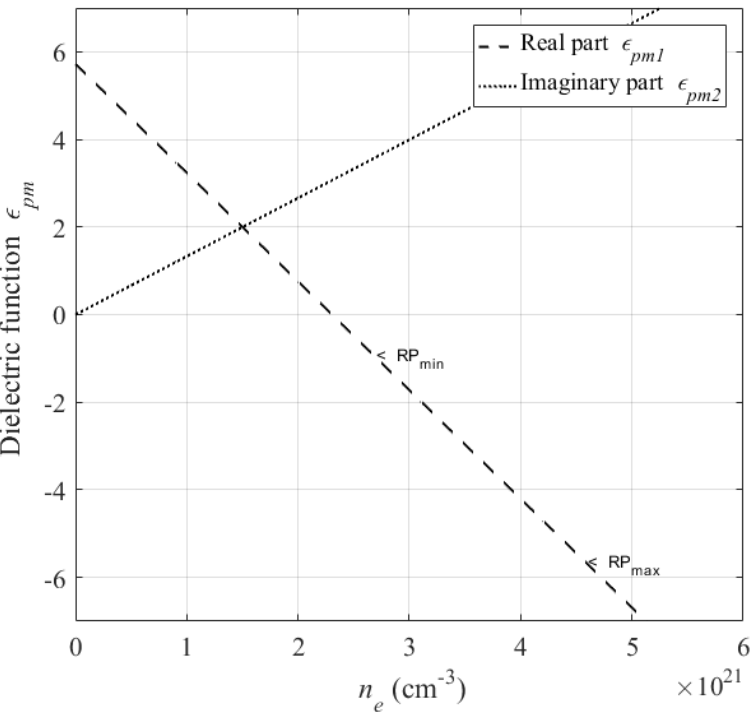
Figure 7. Dielectric function of diamond in function to electron plasma excitation by fs-laser at 1030 nm wavelength. RP min and RP max represent the resonance plasmonic in pseudo-metal/air and pseudo-metal/diamond interface, respectively.